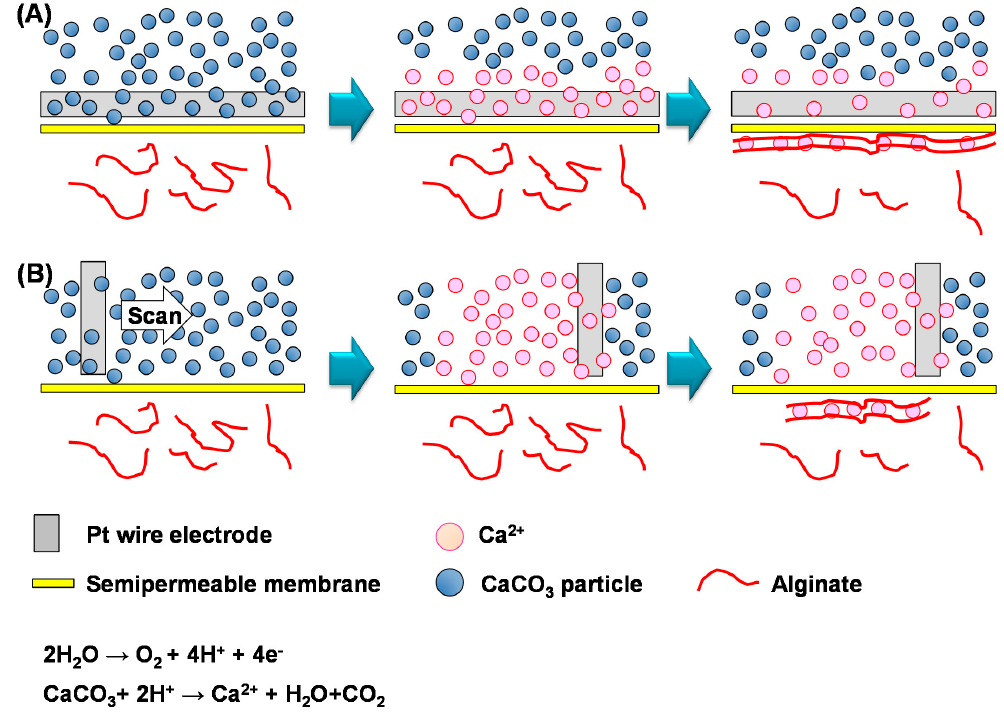
Figure 1. Schemes for the electrochemical hydrogel lithography of calcium-alginate hydrogels. The CaCO 3 -dispersed solution and the sodium alginate solution were introduced above (Ca 2+ production chamber) and below (gel formation chamber) the membrane, respectively. Electrolysis of water at the Pt wire electrode produced Ca 2+ near the electrode. The Ca 2+ diffused to the sodium alginate solution through the membrane to form hydrogels. During electrochemical hydrogel lithography, the electrode was placed on the membrane ( A ) or scanned ( B ).